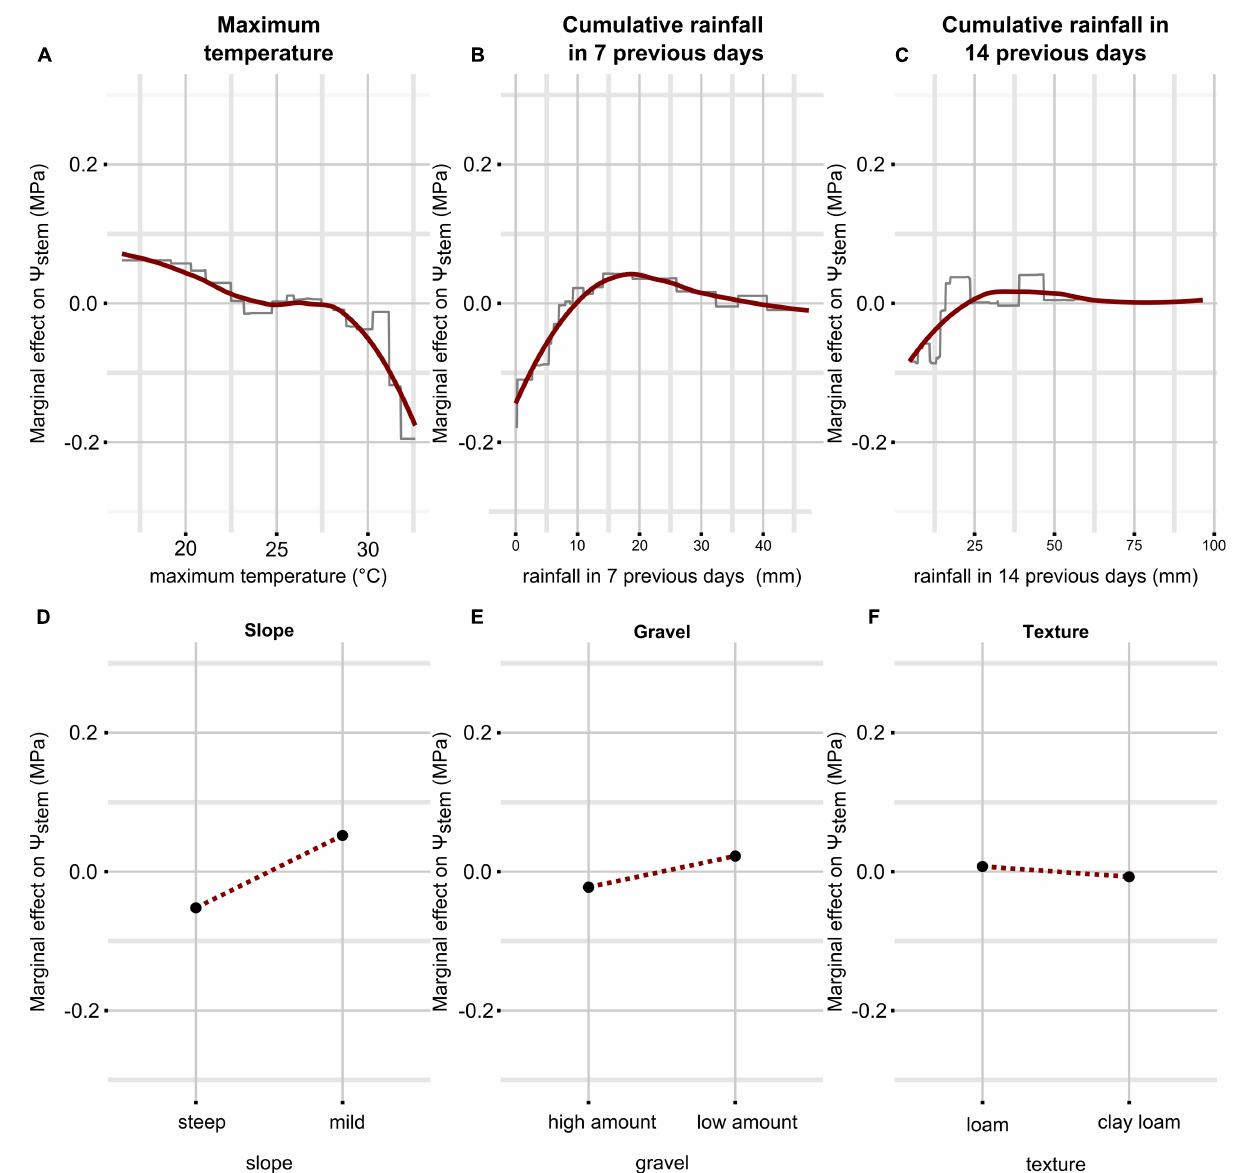
FIGURE 2 | Partial dependence plots for each predictor in the (cid:57) stem model. Only simple relationships (no interactions) are shown. They have been obtained by predicting (cid:57) stem while fixing all predictors to their mean value except the one in question, which was allowed to finely vary across the range of observed data. On the y axis there is the marginal effect on (cid:57) stem , i.e., when it has a 0 value, (cid:57) stem is estimated to its mean by the predictor in question, when it has a value different from 0, (cid:57) stem is estimated higher or lower than its mean by the corresponding value. On the x axis there is the range of observed data for the predictor in question. The essential relationships between predictor and outcome are captured in a smoothed fashion by the red line which is a loess applied to the partial prediction data. The gray lines are original functions as based on the trees used in the models. When the predictor is discrete (as for soil properties), the function shown in the partial dependence plots is also discrete and has a single value for each level of the predictor (soil properties are binary here, then two values). See text for detailed description. Plot (A–F) shows partial dependence plots between predictor and outcome: (A) for temperature, (B) for cumulative rainfall in 7 previous days, (C) for cumulative rainfall in 14 previous days, (D) for slope, (E) for gravel, (F) for